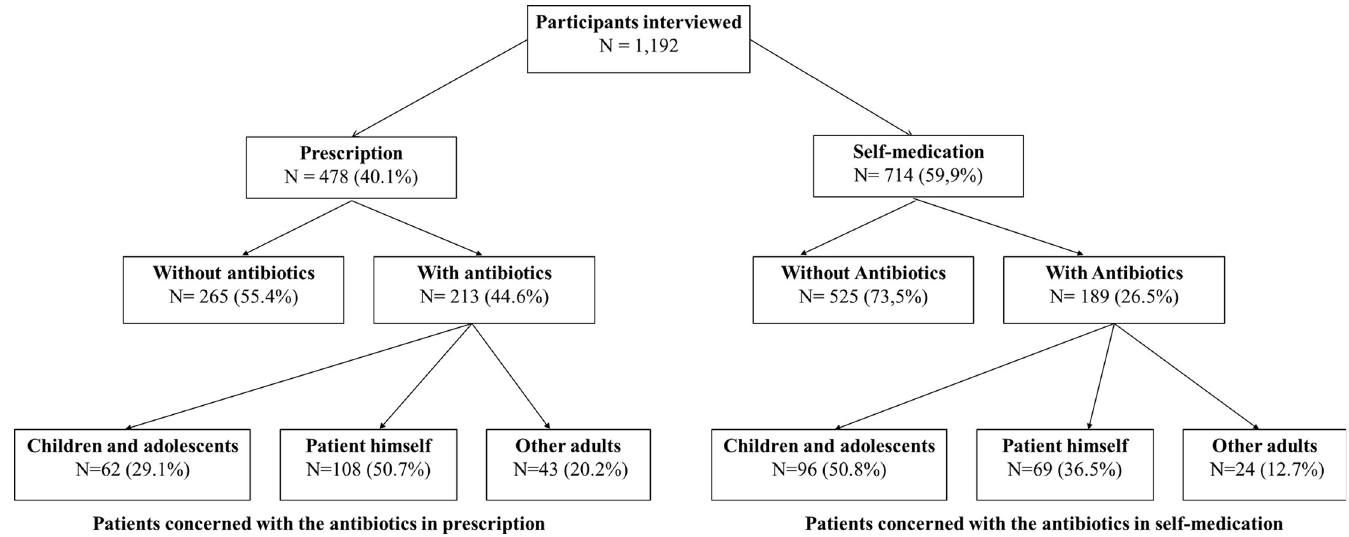
Fig 1. Flow chart of participants through the study according to the type of medication.